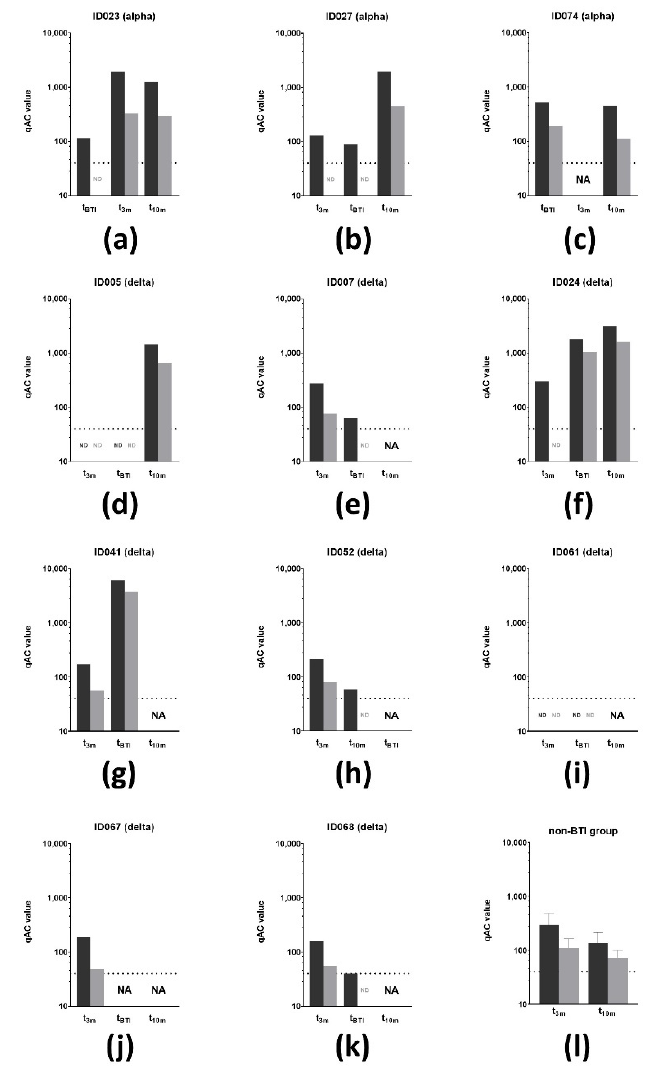
Figure 7. VSV pseudovirus neutralization of SARS-CoV-2 VoC ( n = 11). ( a – c ) qAC50 values (log10) against both D614G (dark grey) and delta (light grey) VoC for three subjects that experienced a BTI caused by the alpha VoC. Two subjects developed a BTI before t 3m , while the other subject developed this between t 3m and t 10m . ( d – k ) qAC50 values (log10) against both D614G (dark grey) and delta (light grey) VoCs for eight subjects that experienced a BTI caused by the delta. ( l ) Mean qAC50 values against both D614G (dark grey) and delta (light grey) VoCs of the non-BTI group at mid- and long- term follow-up. Dotted line = assay-specific LOD. Importantly, data points below the LOD were not included in the graph and thus were excluded for statistical analyses. Error bars represent mean with SD. Abbreviations: VSV = vesicular stomatitis virus, VoCs = variants of concern, BTI = break- through infection. qAC50 = ’qualified AC50’: 50% activity against SARS-CoV-2 variant, NA = not available, ND = not detectable (i.e., below assay-specific LOD), 3m = 3 months after baseline, 10m = 10 months after baseline, LOD = limit of detection, SD = standard deviation.